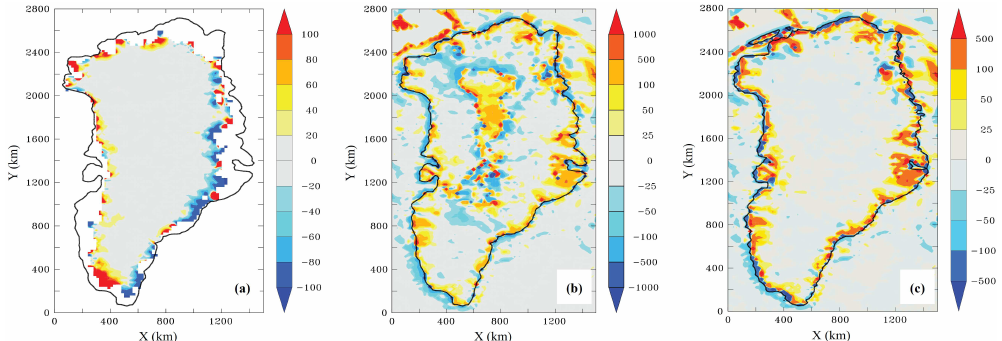
Figure 2. (a) The ratio of the difference between ice thickness of the Bamber dataset and ice thickness of the Letreguilly dataset (cid:0)(cid:0) z (cid:1) /z (cid:1) expressed as a percentage. The regions of largest relative difference occur around the margins with good agreement between the datasets in the ice-sheet interior. (b) The ratio of the difference in initial bedrock topography of the Bamber dataset and the topography of Letreguilly expressed as a percentage. Again the largest differences occur around the margins of Greenland and also in the central region where the bedrock is below sea level. (c) The ratio of the difference in relaxed bedrock topography after the removal of ice and isostatic equilibrium has been reached expressed as a percentage. The resultant orography shows the relative difference around the margins of up to 500%, with the Bamber orography significantly